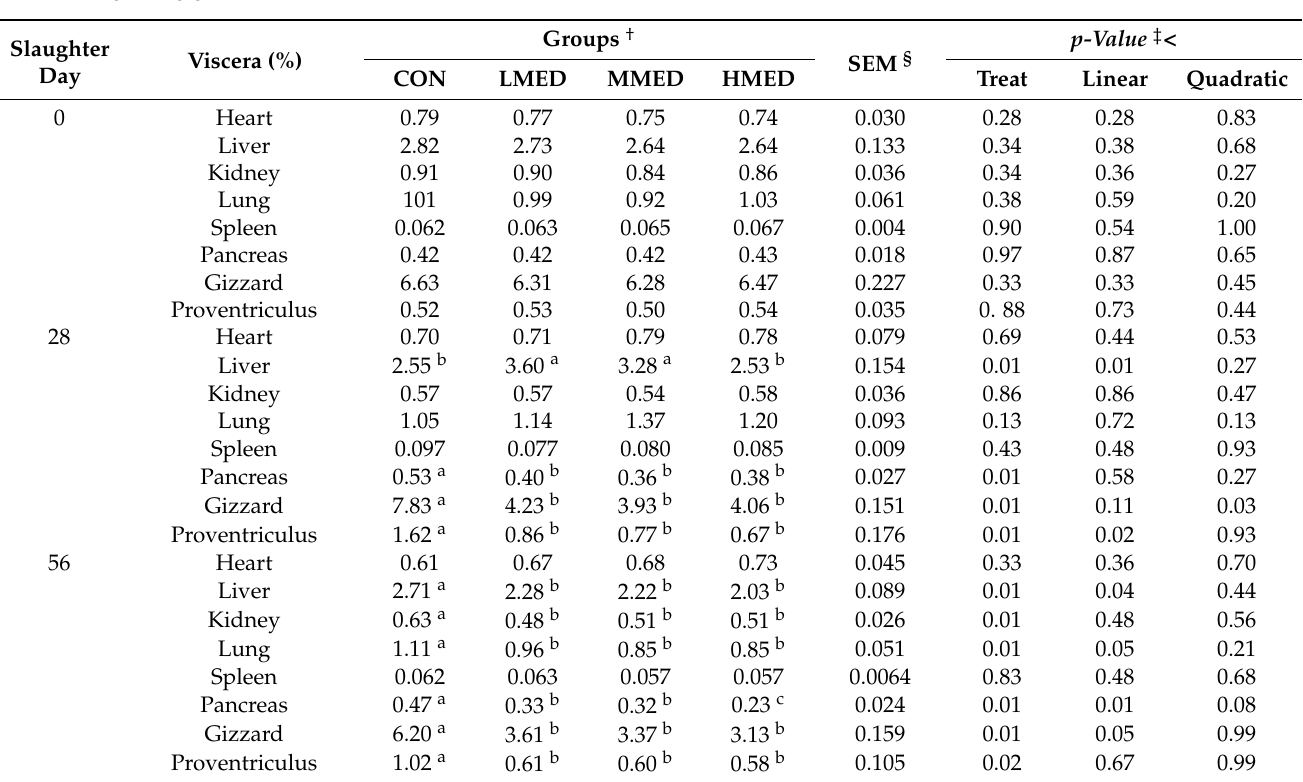
Table 7. Effects of supplemental feeding diets with three levels of metabolizable energy (ME) on relative weights of viscera (%) of grazing